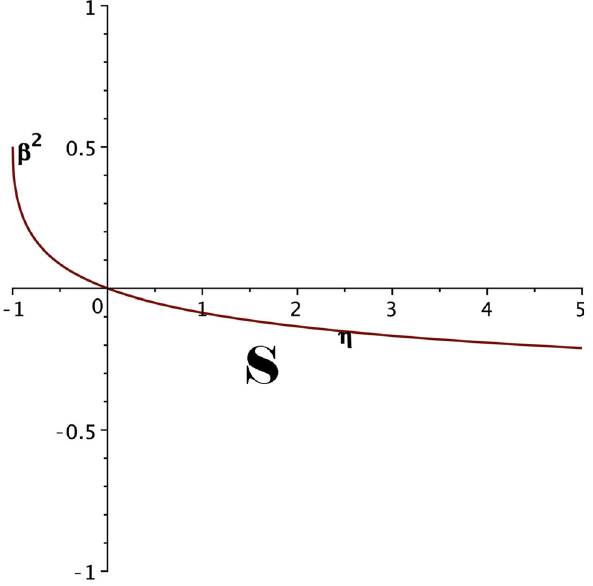
4 An S–S TSW with different central